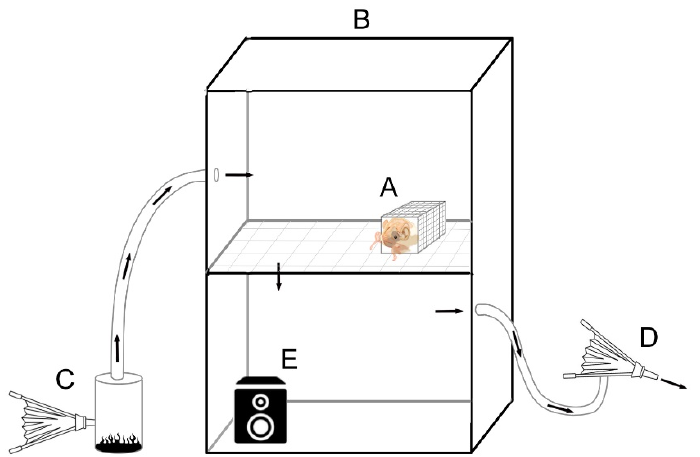
Figure 1. Experimental set up for lab-based trials with directionality of smoke indicated. The bat ( A ) was placed in a cage with no barriers blocking the scent or sound of stimuli on the top shelf of the environmental chamber ( B ). Depending on the experimental trial, air/smoke was forced through the chamber using the bellows ( C ) and removed on the opposite side ( D ), passing through tubing, and sound was emitted through the speaker ( E ) in the bottom of the chamber. Bats were subjected to these stimuli individually and concurrently during trials.